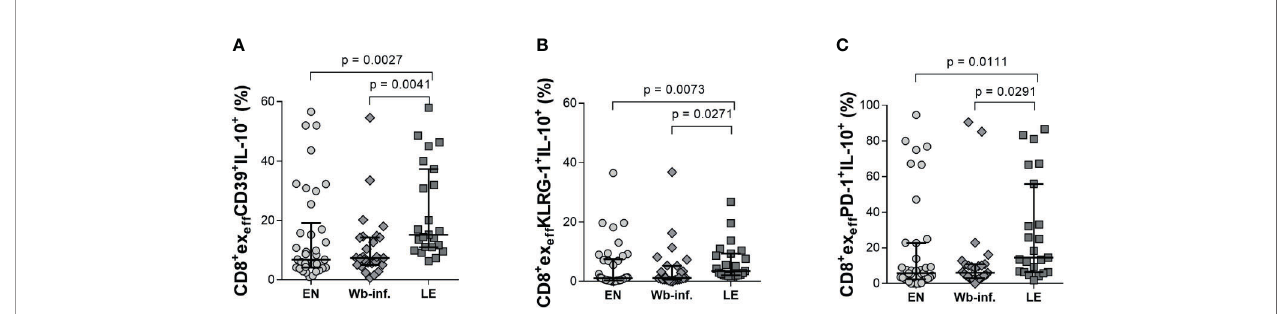
FIGURE 5 | Increased levels of IL-10 in CD39 + , KLRG-1 + , and PD-1 + CD8 + ex eff subsets of lymphedema patients. Cell populations were analyzed according to the applied gating strategy ( Supplementary Figure S3 ). Next, CD39 + - (A) , KLRG-1 + - (B) , and PD-1 + - (C) CD8 + ex eff cell subsets isolated from endemic normal (EN, n = 38), Wuchereria bancrofti infected, (Wb-inf., n = 27), and participants suffering from lymphedema pathology (LE, n = 23) were analyzed for their levels of IL-10 (frequencies shown) by fl ow cytometry. Symbols in graphs show each individual value with median and IQR. Statistical signi fi cance between the groups was obtained by using Kruskal-Wallis followed by Dunn ’ s multiple comparison post